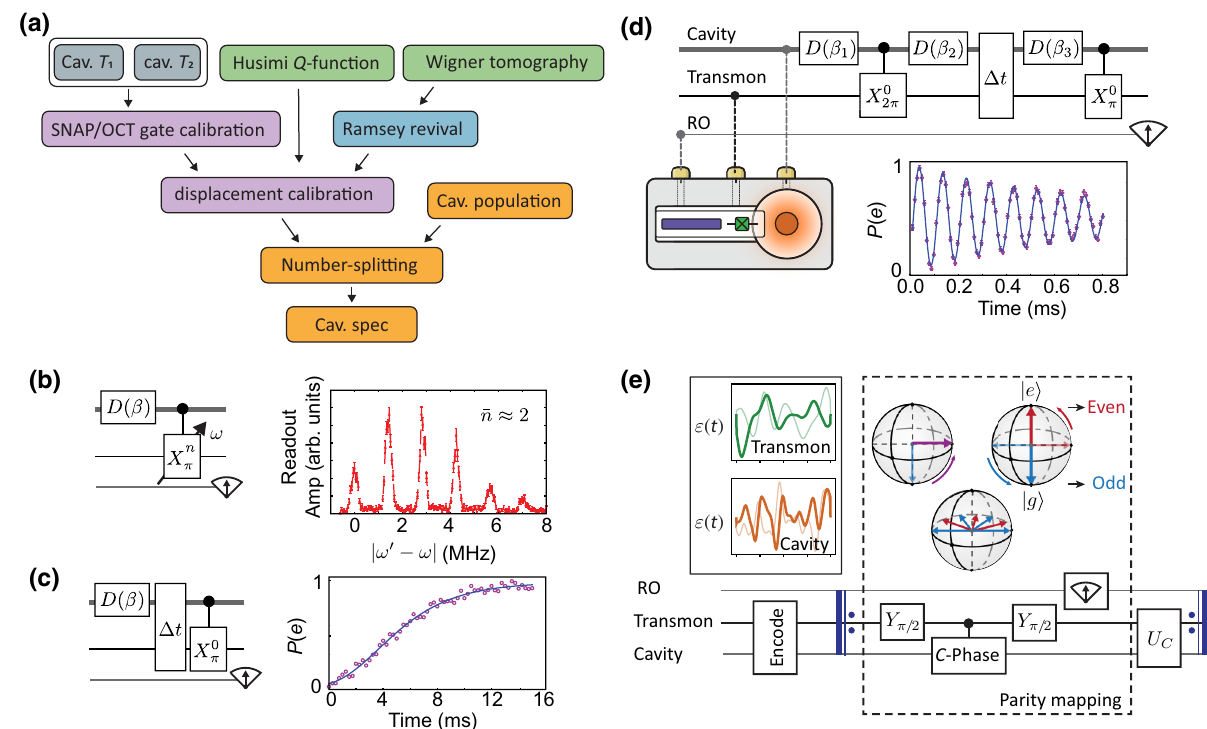
FIG. 17. Standard procedures for characterizing a high- Q cavity mode. (a) A typical cavity characterization process presented as a dependency graph. (b) The gate sequence and outcome of a number-splitting experiment where the transmon’s frequency is shifted when a coherent state is initialized in the cavity. Separation between the peaks corresponds to χ . (c) Energy relaxation timescale of the cavity obtained by initializing it in a large coherent state, followed by a flip of the transmon state conditioned on the cavity in vacuum after a variable delay. (d) The typical cQED hardware for operating a bosonic qubit is composed of a high- Q superconducting cavity (e.g., a 3D coaxial λ/ 4 resonator, orange) for storing the logical qubit, a transmon ancilla (green) for universal control, and a low- Q resonator (e.g., a λ/ 2 stripline resonator, blue) for readout (RO). Universal control of the cavity state can be performed via a transmon ancilla (green) and read out via a planar resonator (purple). A protocol to probe the phase coherence time of the cavity using SNAP gates. (e) A QEC protocol realized by mapping the parity of the logical qubit onto the state of the transmon, followed by the appropriate correction unitary. The logical state is initialized using numerical optimal control pulses